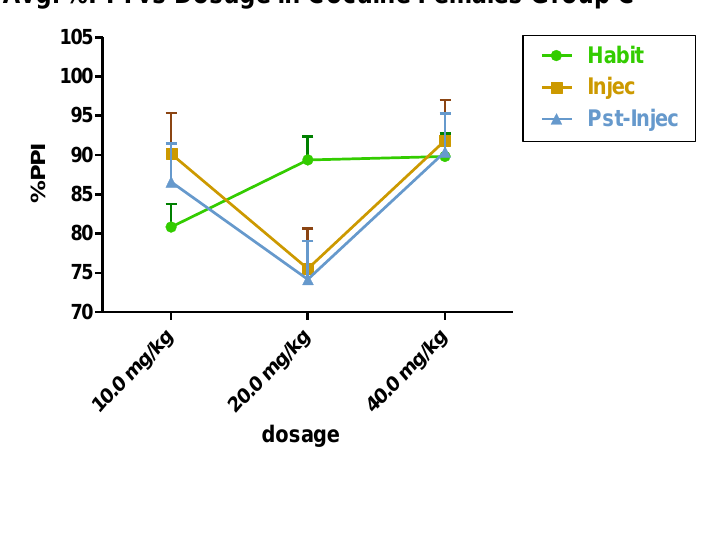
Figure 4. Group C ( n = 6) shows the effect of cocaine in the acoustic startle paradigm in females. Females were isolated from males during the experimental